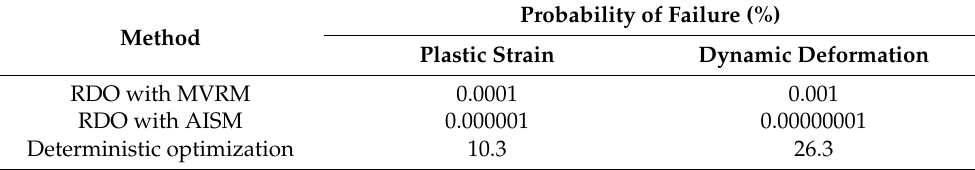
Table 6. Comparison of probability of